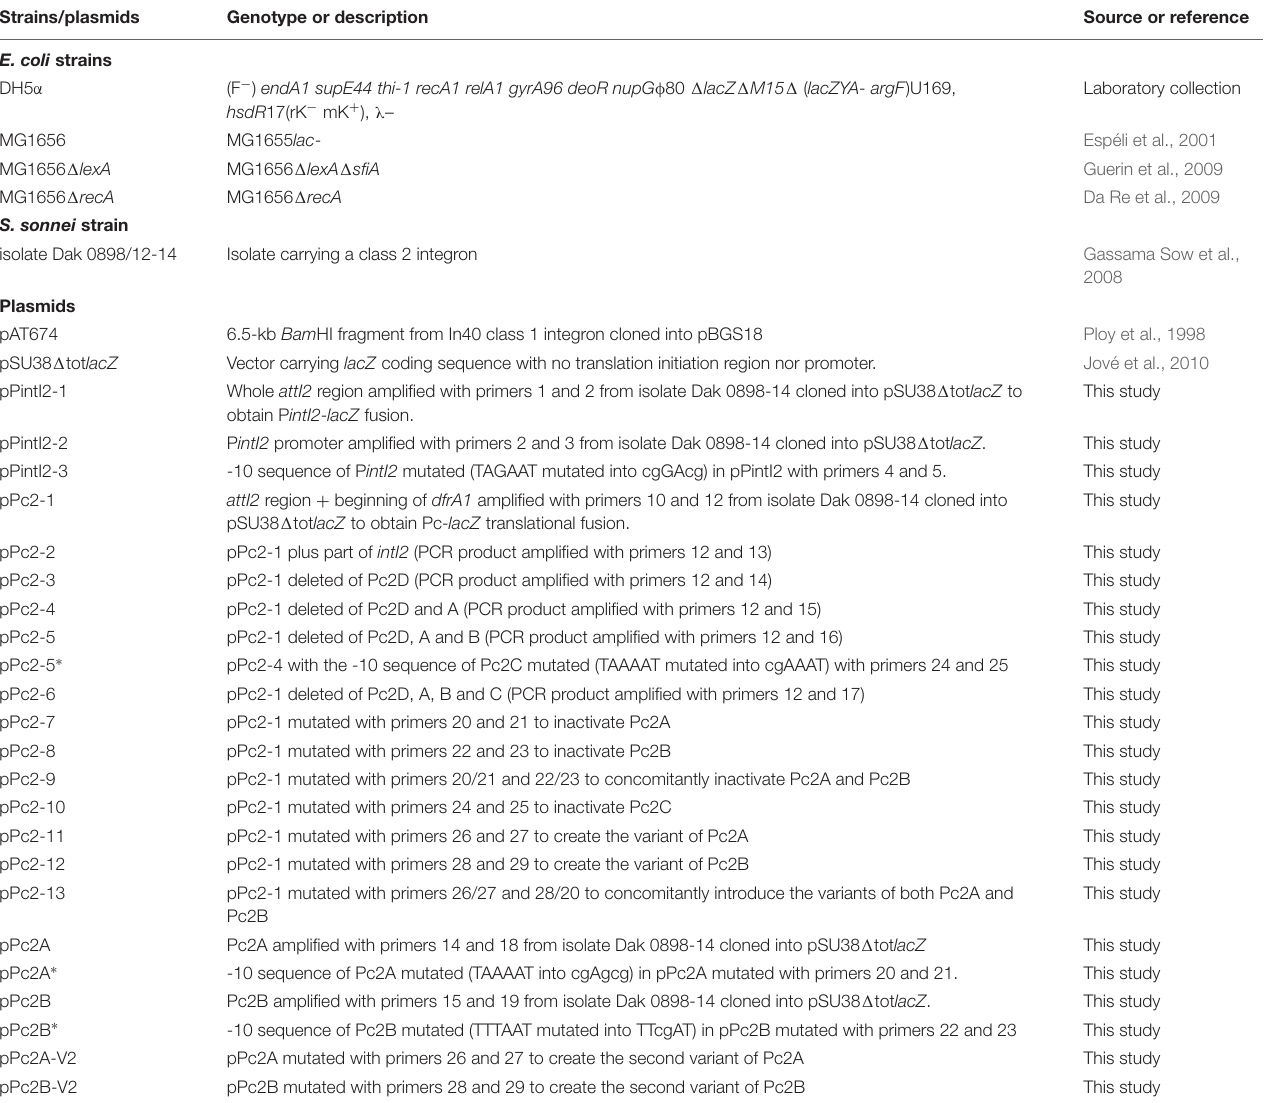
TABLE 1 | Strains and plasmids used in this